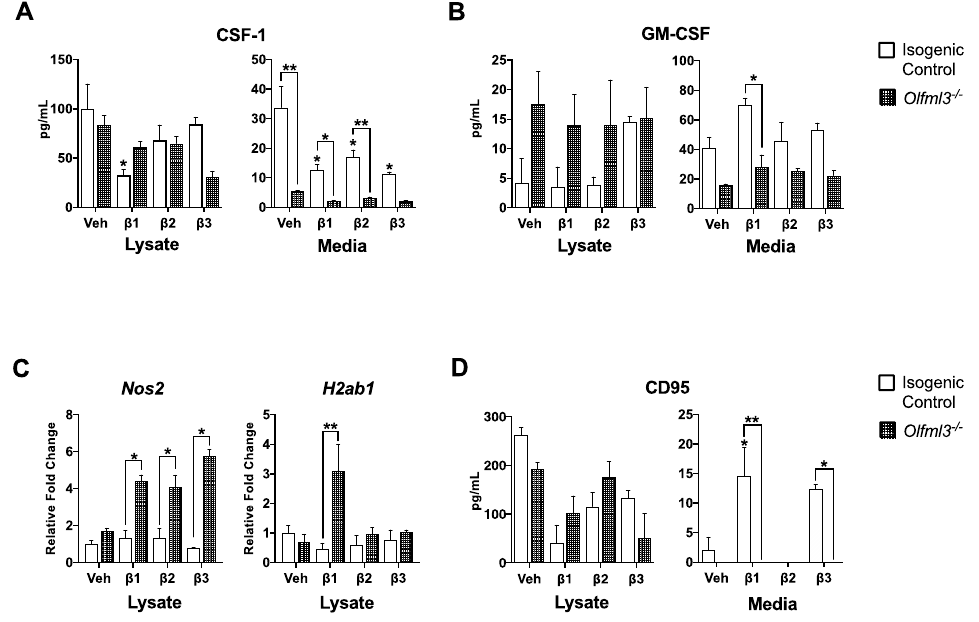
Figure 4. Olfml3 deletion attenuated TGF β -induced microglial immunosuppression. ( A ) Secretion of colony stimulating factor-1 (CSF-1) was attenuated in Olfml3 -/- microglia relative to isogenic control microglia in all conditions; * p < 0.05, ** p < 0.01. ( B ) While exposure to β 1 increased secretion of granulocyte–macrophage colony stimulating factor (GM-CSF) in isogenic control microglia, secretion was reduced in Olfml3 -/- microglia; * p < 0.05. ( C ) The mRNA levels of the pro- inflammatory genes Nos2 and H2ab1 were increased in Olfml3 microglia relative to isogenic control cells following treatment with TGF β ; * p < 0.05, ** p < 0.01. ( D ) Secretion of CD95, a potent inducer of cytotoxic T cell apoptosis, increased in isogenic control microglia following exposure to β 1 and β 3, but was undetectable in the media of Olfml3 -/- microglia across all conditions; * p < 0.05, ** p < 0.01. Comparisons based on one-way ANOVA with Tukey’s Multiple Comparison Test. Bars represent group mean with standard error of the mean (SEM); data represent one of three independent ex- periments.